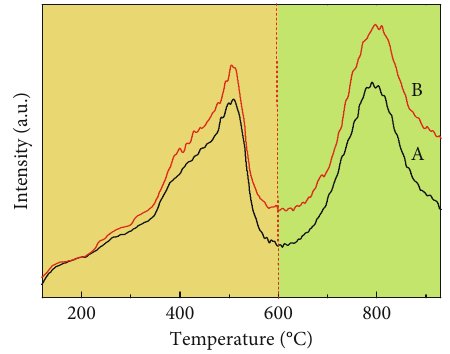
Figure 3: H -TPR pro fi les of (a) Blank- and (b) MEA-CeO 2 powders synthesized by solvothermal process combined calcination in air.